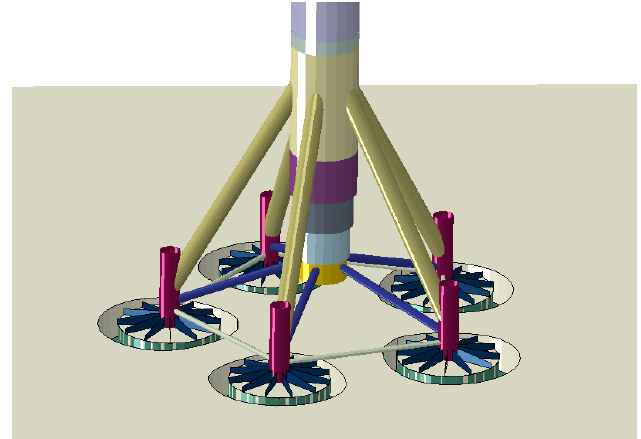
Figure 14. Finite element model of scoured seabed.